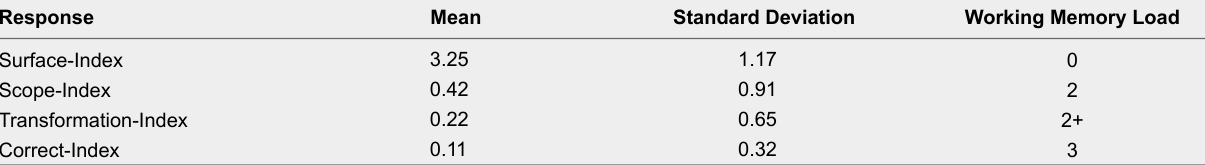
Response Pattern for DeMorgan´s Law 1